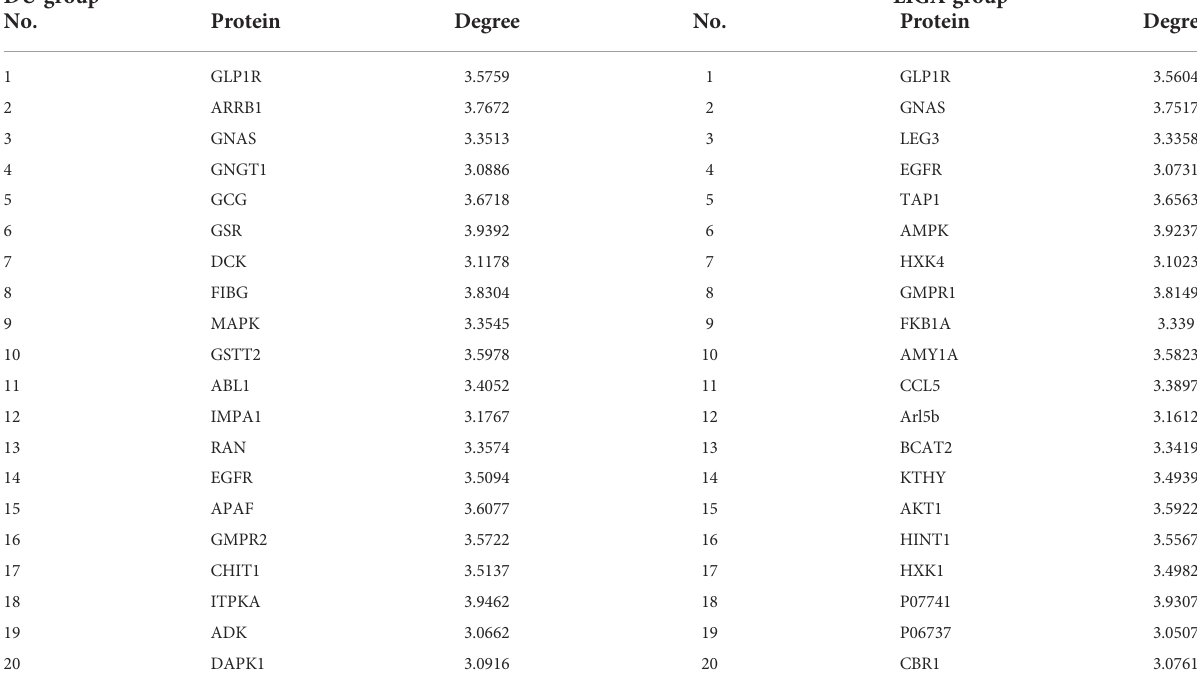
TABLE 3 The proteins of key protein-metab1ite network in the DU and LIGA groups. DU group LIGA group